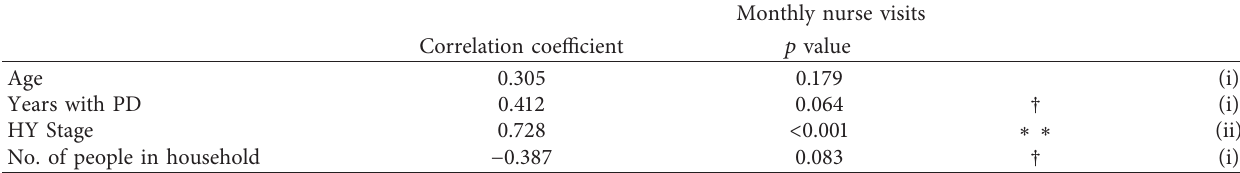
Table 3: Correlations between participant (patient) characteristics and monthly nurse visits ( n �